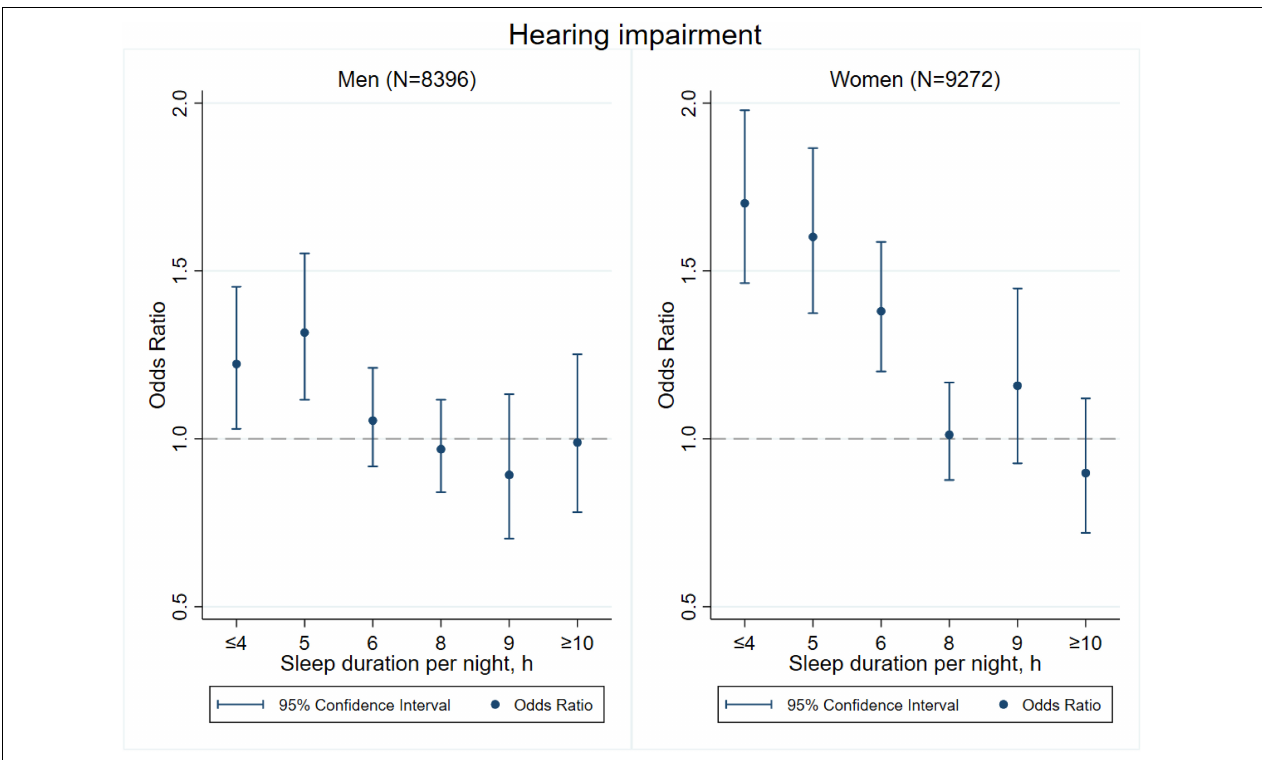
FIGURE 4 | Gender-specific effect of sleep duration on hearing impairment.